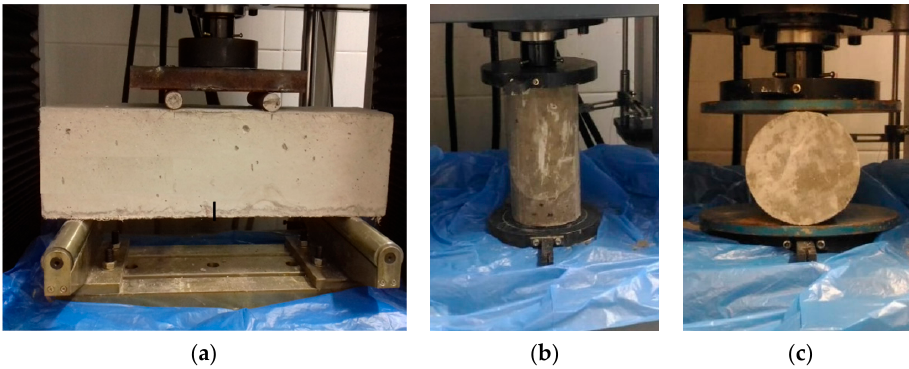
Figure 11. ( a ) Four-point bending test, ( b ) compression test, ( c ) tension indirect test.